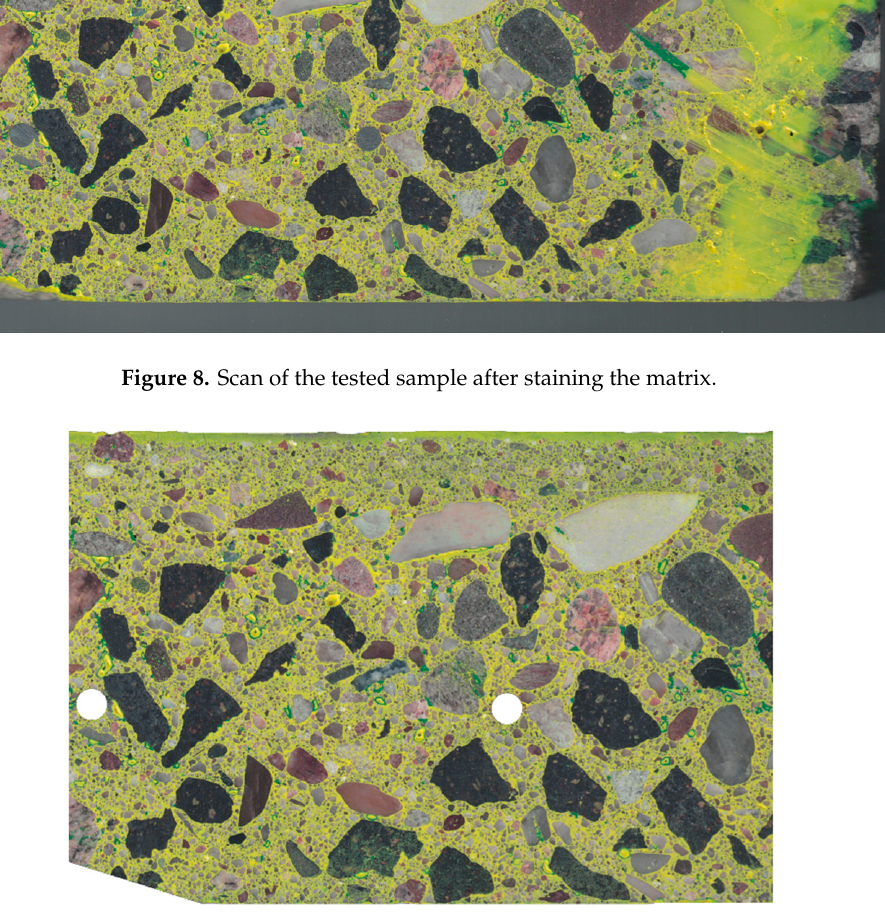
Figure 8. Scan of the tested sample after staining the matrix.